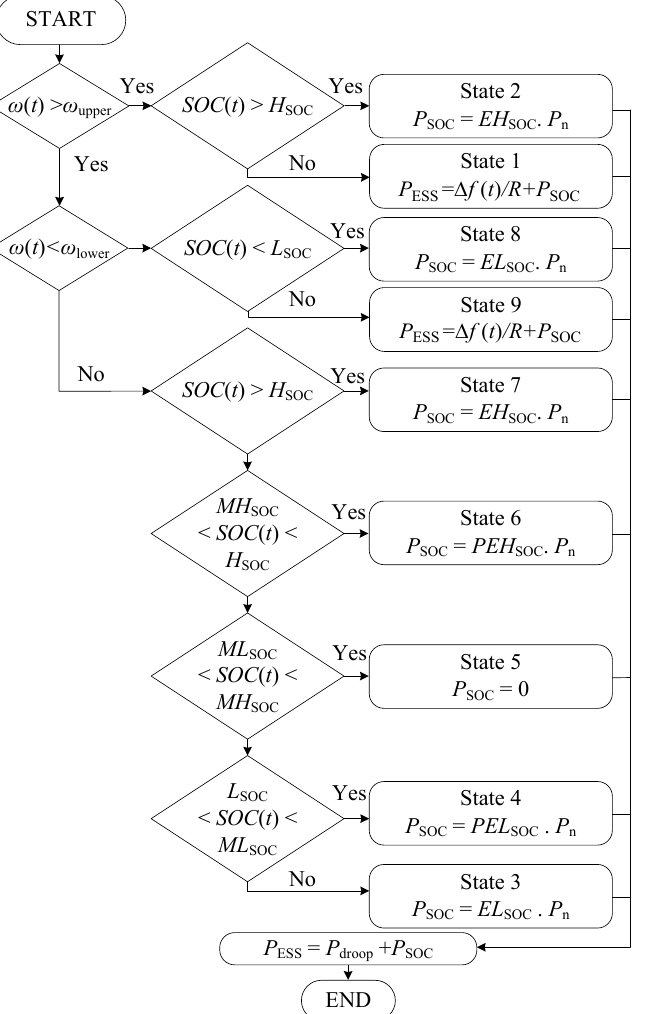
Figure 7. Flow chart of implemented algorithm for frequency regulation and SOC